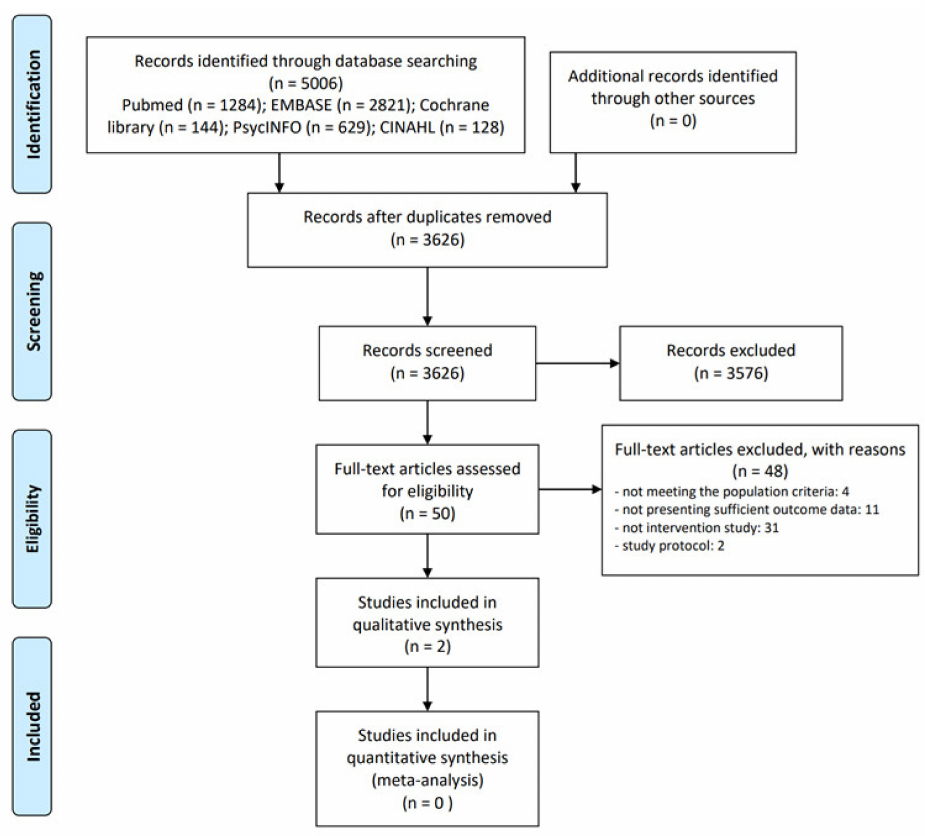
Figure 1. PRISMA flow